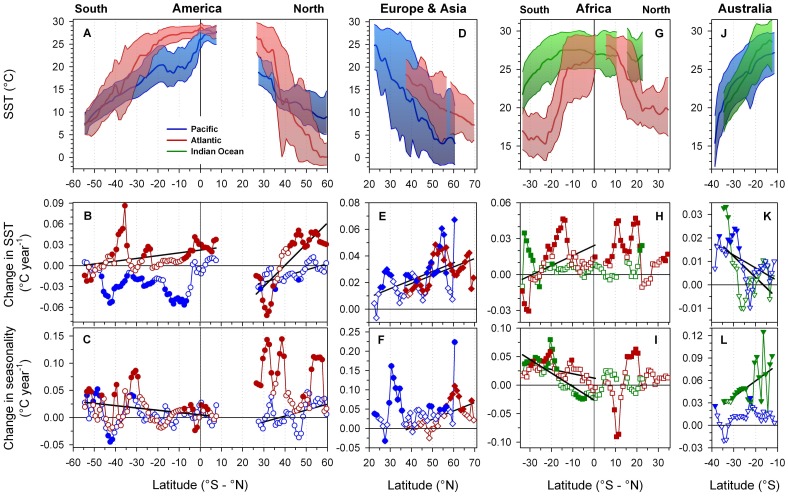
Spatio-temporal temporal patterns of the world's major coastal latitudinal temperature gradients.Upper panel row (A, D, G, J): latitudinal patterns in long-term average SST (thick line), average SST minima and maxima (thin lines) and seasonality (shaded area). Middle panel row (B, E, H, K): latitudinal patterns in 31 year SST trends, with positive and negative slopes indicating warming and cooling, respectively, at specific latitudes.Bottom panel row (C, F, I, L): latitudinal patterns in 31 year trends in seasonality (SSTmax-SSTmin). Empty and filled symbols depict non-significant and significant linear regressions, respectively (p<0.05). Significant (p<0.05) latitudinal trends in middle and bottom panel rows are indicated by solid regression lines (black). Atlantic Ocean gradients: red lines, shades and symbols; Pacific Ocean gradients: blue lines, shades and symbols; Indian Ocean gradients: green lines, shades and symbols. Positive and negative latitudes refer to the northern and southern hemisphere respectively.